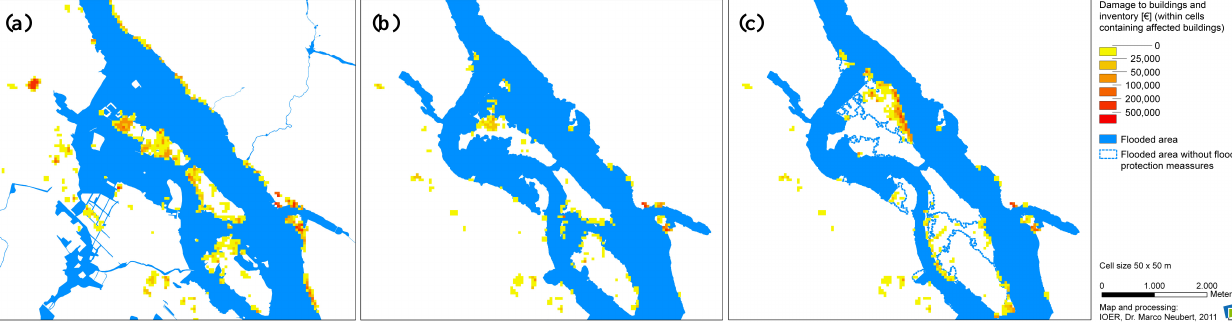
Fig. 11. Damage to buildings and inventory caused by groundwater inundation shown as damage cells for the 2002 flood event (a) and two 100-yr ARI winter flood scenarios (b, c) ; (b) : without flood protection measures (c) : with flood protection measures; data sources: flooded areas: Dresden City